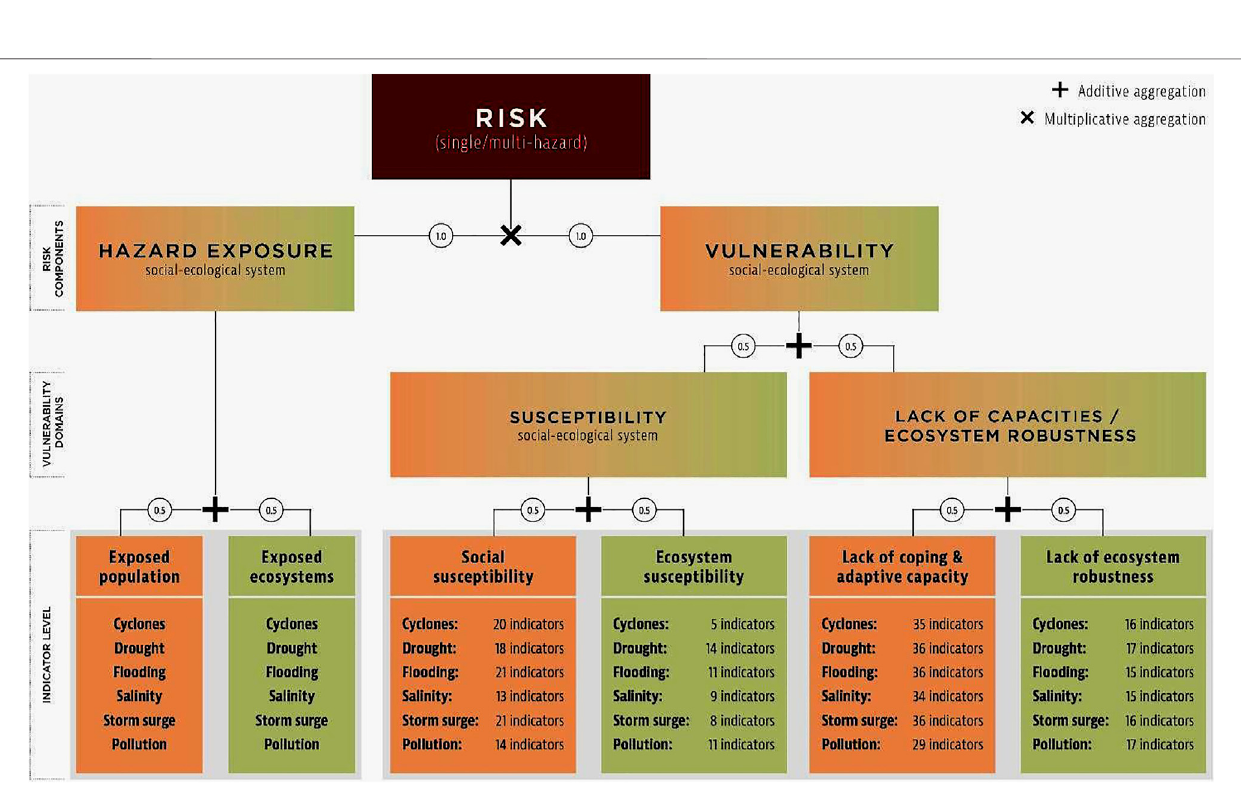
Frontiers in Earth Science |